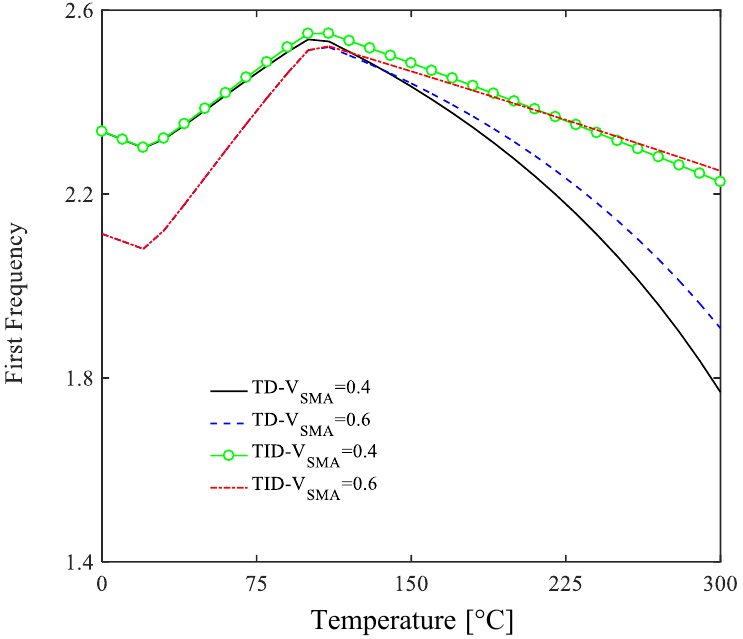
Figure 14. Variation of the first dimensionless frequency vs. temperature for both TD and TID properties, different SMA volume fraction powers, and a uniform temperature distribution ( n = 1, h c / h = 0.5 and ε 0 = 2% ).